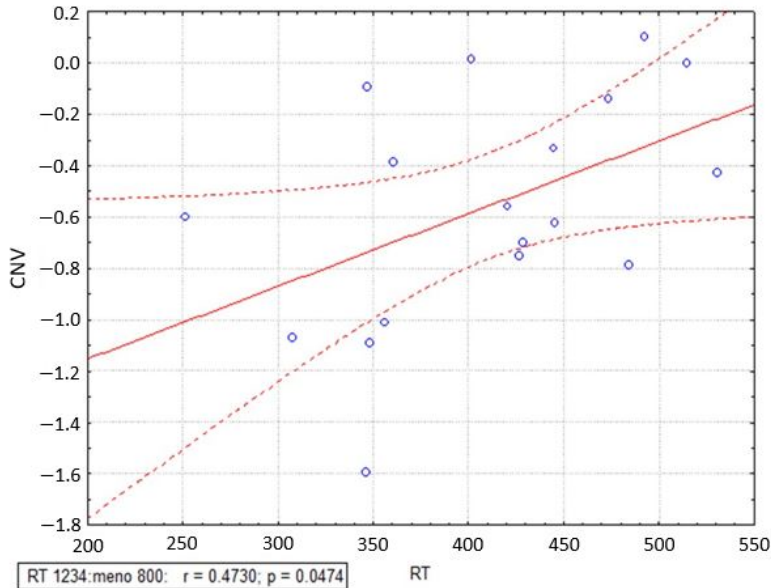
Figure 8. Correlation analysis between contingent negative variation (CNV) mean values and reaction times (RTs). The correlation line between the two types of data is represented as continuous while the correlation con fi dence intervals are shown as dashed lines.